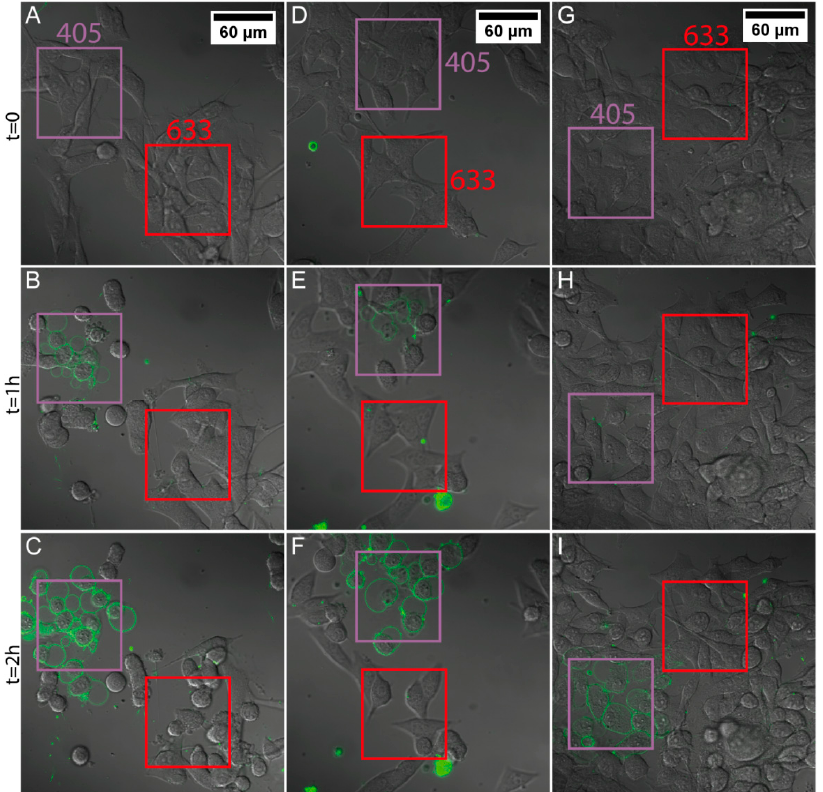
Figure 5. Rate of apoptosis induction in the B16F10 mouse melanoma cells exposed to the PDA/protein NPs, upon light irradiation. The melanoma cells were exposed to 20 μ g/mL PDA/Tf NPs ( A – C and Supplementary Video 4), PDA/HSA NPs ( D – F and Supplementary Video 5), or media only ( G – I and Supplementary Video 6). Similar to Figure 3, two regions, per field, were defined, one